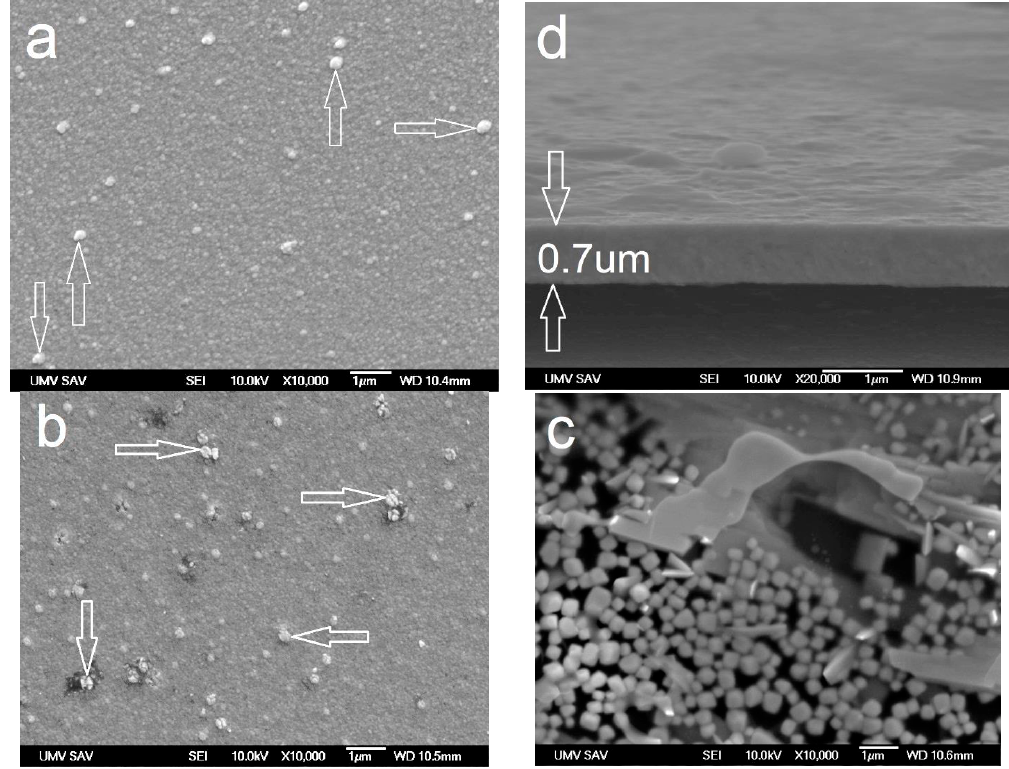
Figure 5. Morphology of the surface and cross-sectional brake of WC/C coating deposited with Ar (added gas): ( a , d ) RT and annealed at ( b ) 500 °C and ( c ) 800 °C (SEM).